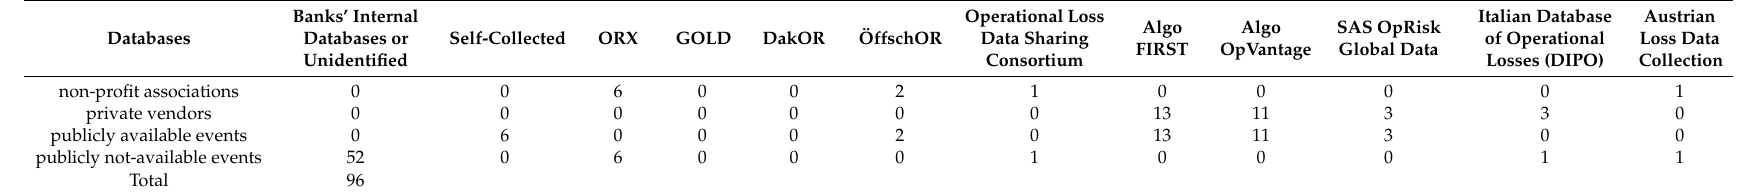
Table 3. Operational loss